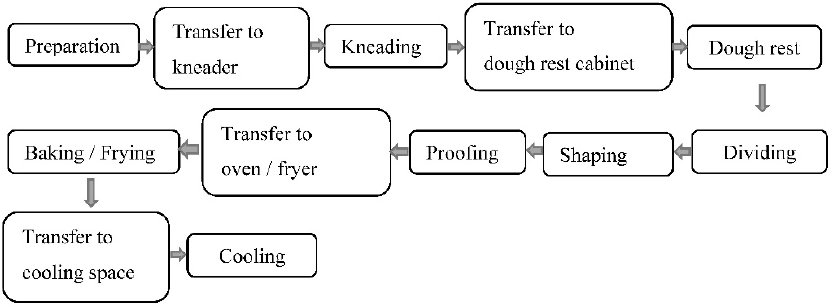
Figure 1. A simplified processing route for bakery products.